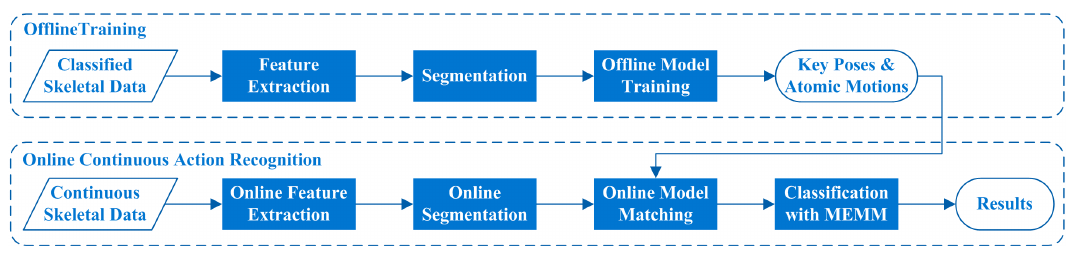
Figure 1. Overview of the proposed algorithm.